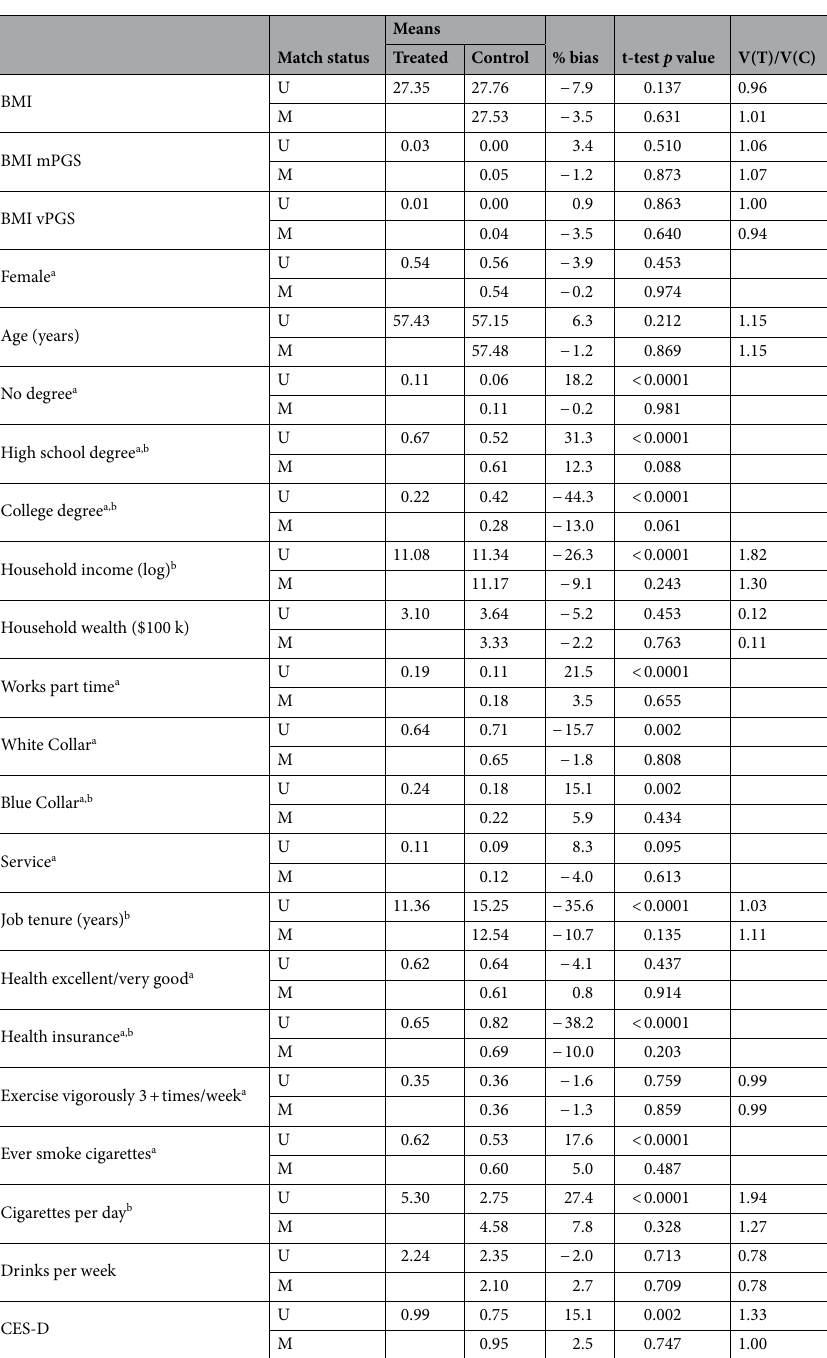
Table 1. Before treatment means of treated workers who lost their job due to a business closure, control workers, and matched controls. a Indicates a variable is binary. b Indicates a variable is not balanced after matching ( p value < 0.05 or standardized bias > 5%). Abbreviations: U, unmatched; M, matched; % bias: percent standardized bias; CES-D, Center for Epidemiological Studies-Depression 8 item scale. The t-test p value refers to the p value from the difference in means between the treated and control groups before and after matching. The V(T)/V(C) column presents the ratio of a continuous variable’s variance for the treatment group over the variance for the control group. Additional covariates in the matching procedure: marital status, firm size, industry, survey year, regional Census division, additional categories for variables with missing values, and the first 10 principal components of the European ancestry genetic data. We used kernel-based propensity score matching with a bandwidth of 0.06. Unmatched control observations = 11,629; Unmatched treated observations = 399; Matched control observations = 11,559; Matched treated observations =